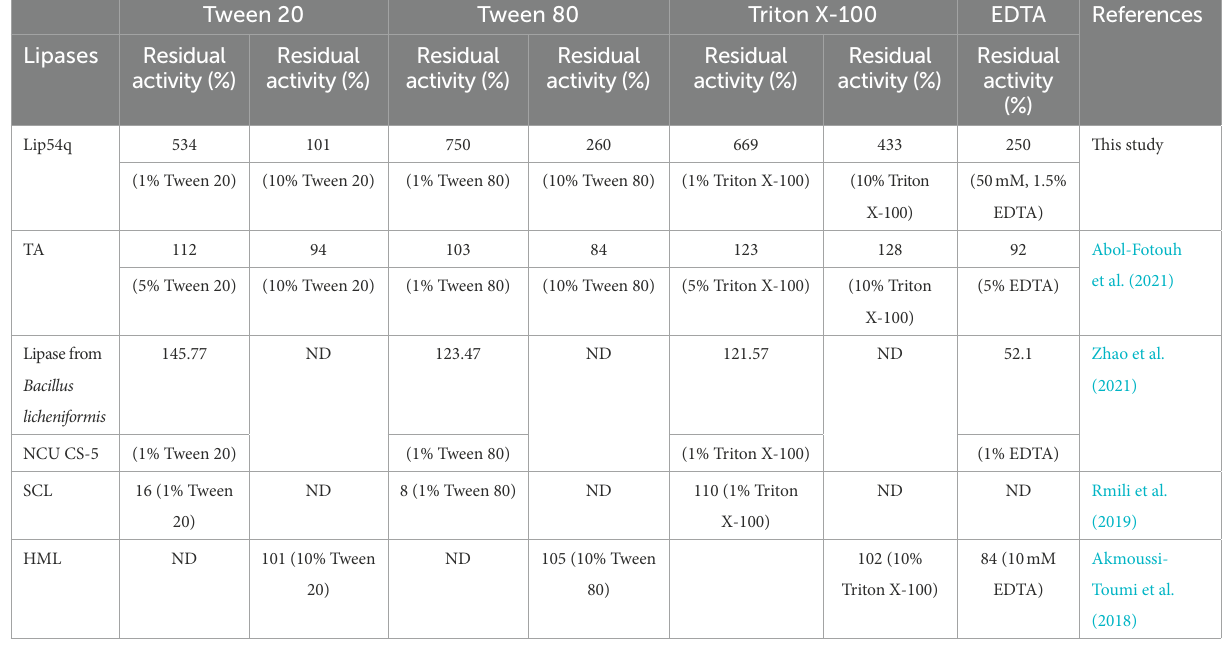
TABLE 6 Comparisons of tolerance to several surfactants and EDTA of Lip54q with several lipases used for detergent